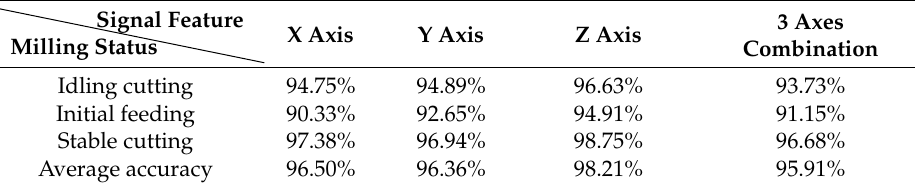
Table 3. Identification result using FS screening features and removing features not related to rotation